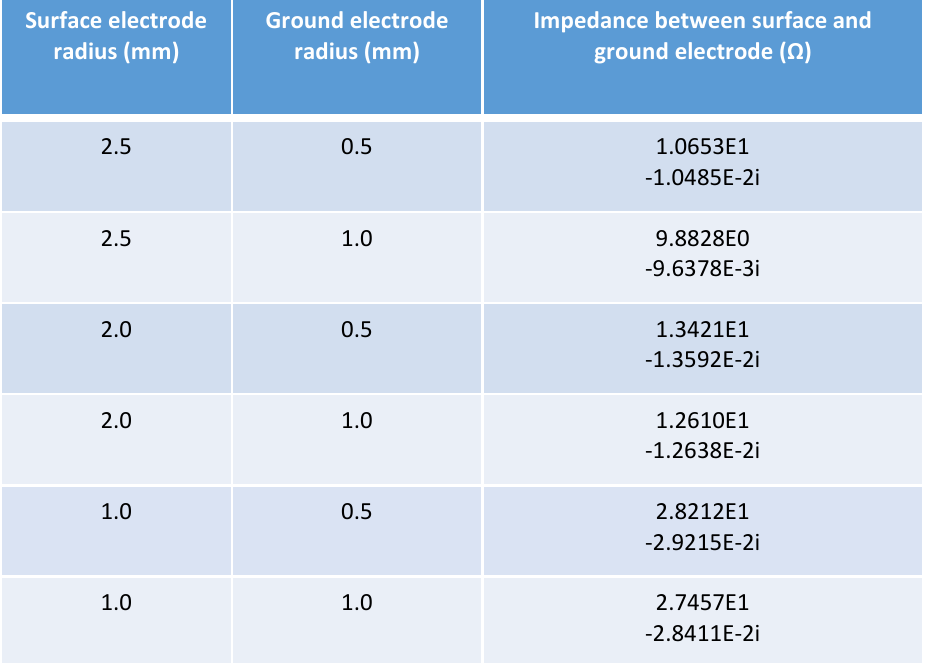
Table.7: Impedance measurement at 1MHz with all the 32 surface electrodes excited simultaneously as terminals (8 electrodes in 4 rows)